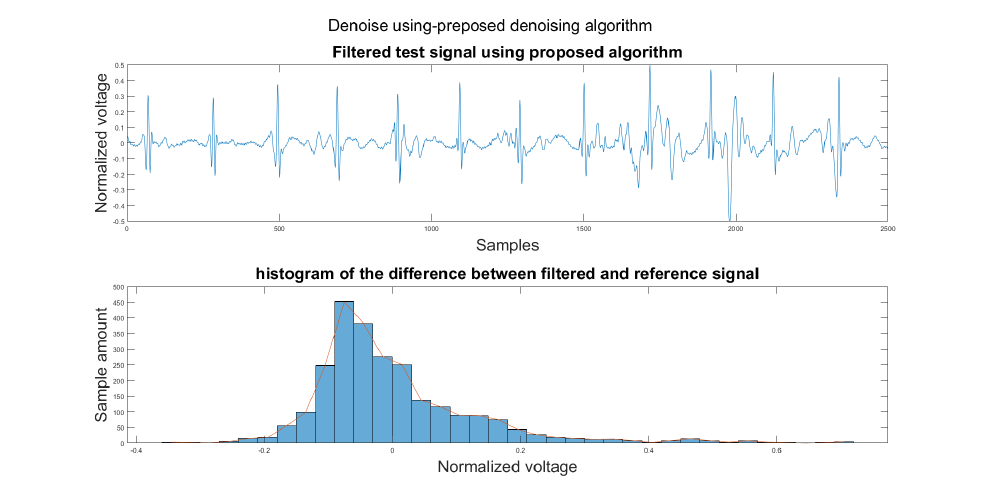
Figure A14. (1) Test signal, (2) histogram of the